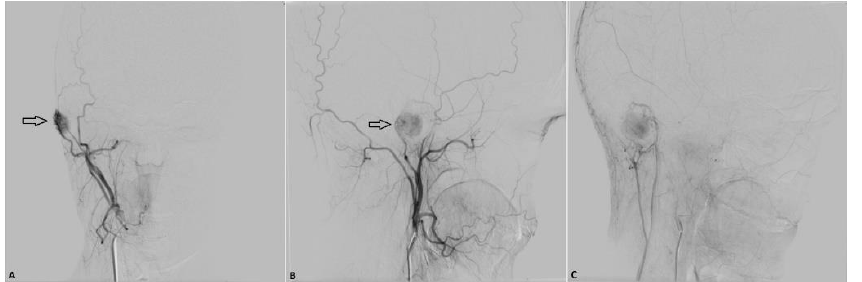
Figure 3. Diagnostic digital subtraction angiography (DSA). ( A , B ) Anteroposterior (AP) ( A ) and lateral projection ( B ) in the arterial phase after injection in the right external carotid artery showing a well-vascularized tumor (arrow) with arterial supply from the posterior auricular artery on the right side. ( C ) Lateral projection in the venous phase showing venous drainage from the tumor into the external jugular vein on the right side. Diagnostics 2021 , 11 , x FOR PEER REVIEW